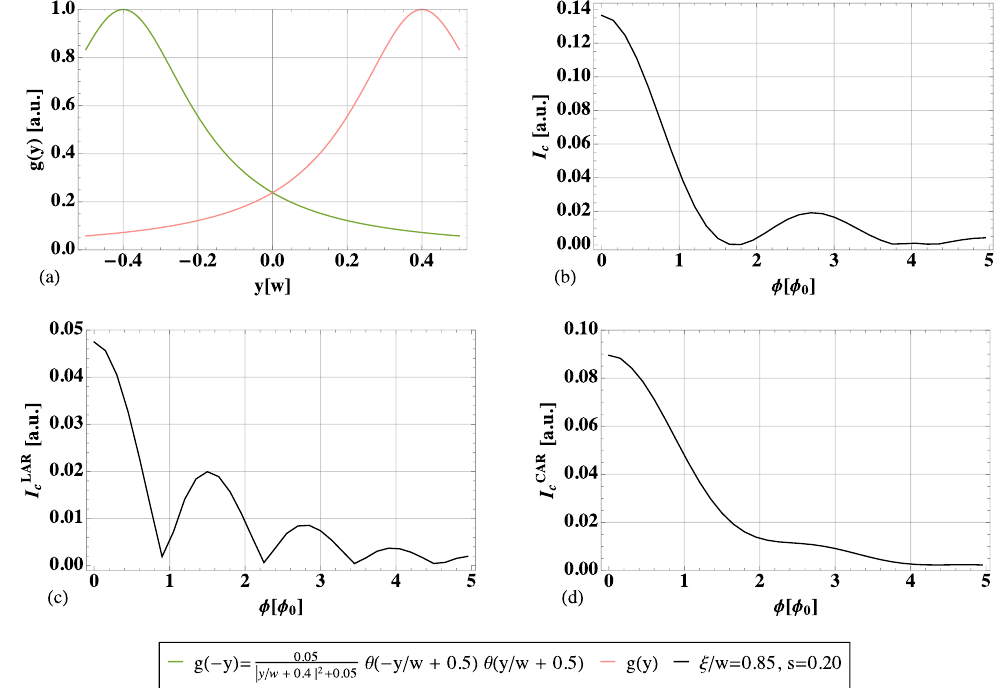
Figure 3. Resultant interference pattern I C ( φ ) (panel ( b )) and the separated contributions of LARs (panel ( c )) and CARs (panel ( d )) for the edge profile in panel ( a ), ξ / w = 0.85 and s =